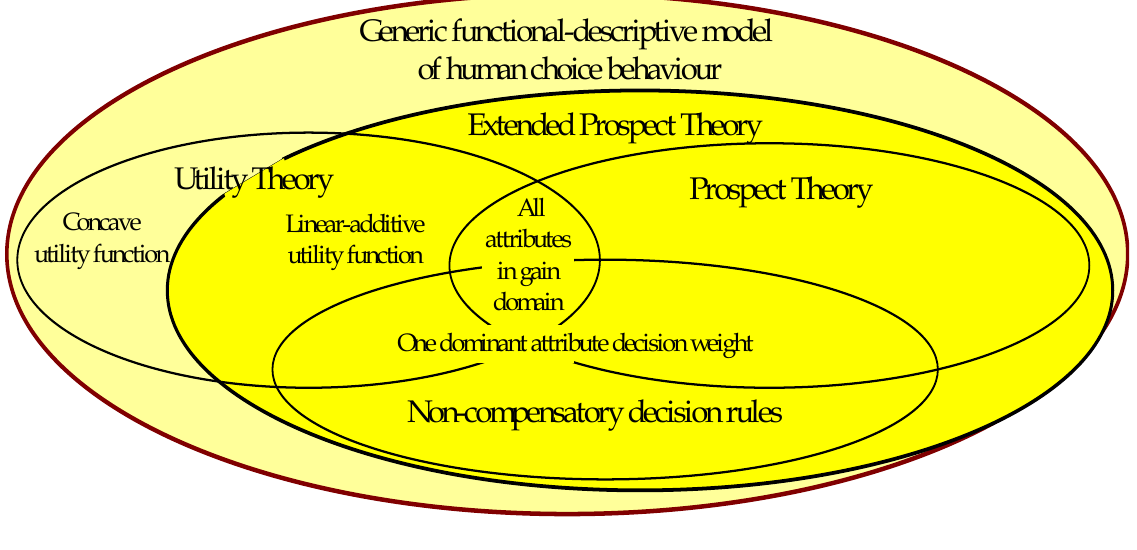
Figure 2. Venn-diagram of choice behaviour theories 13